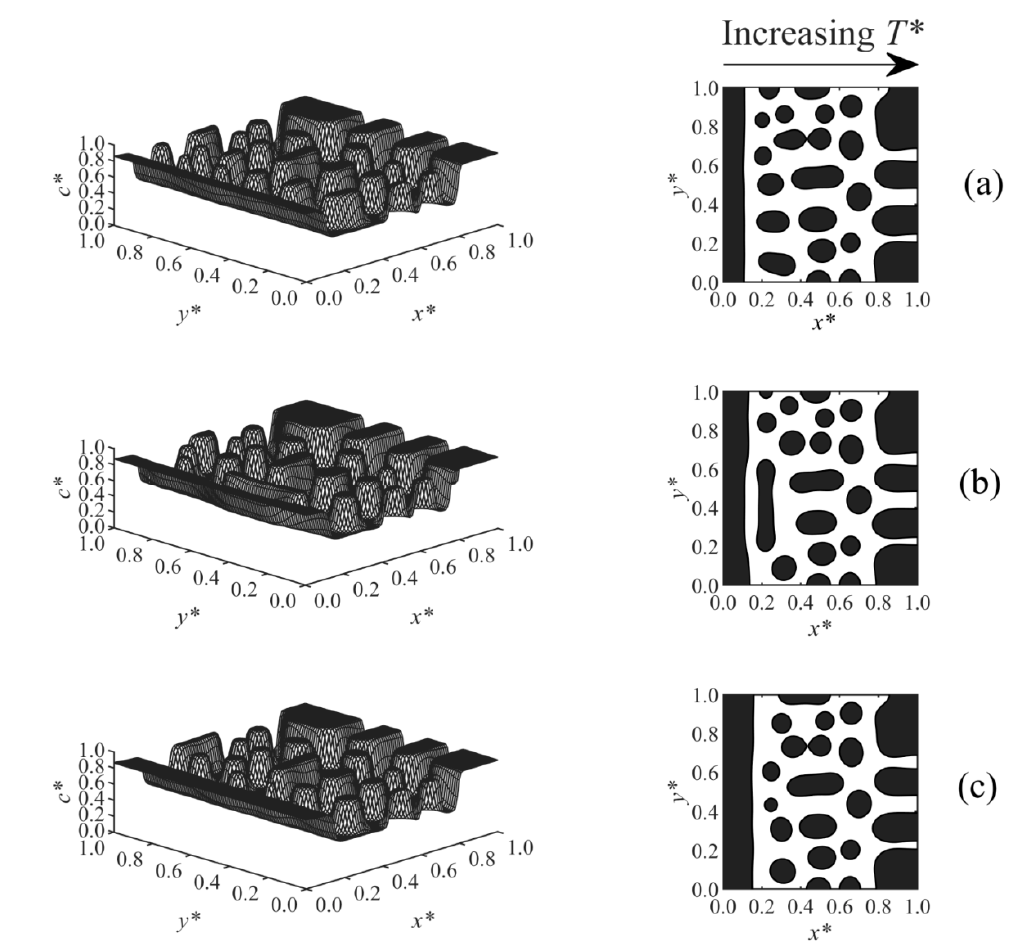
Figure 8. Spatial concentration distributions (first column) and phase-separated morphologies (second column) for Case 6 at t * = 5.75 × 10 − 5 and the following surface potential parameters: ( a ) h 1 = 0.5, ( b ) h 1 = 1, and ( c ) h 1 = 2.